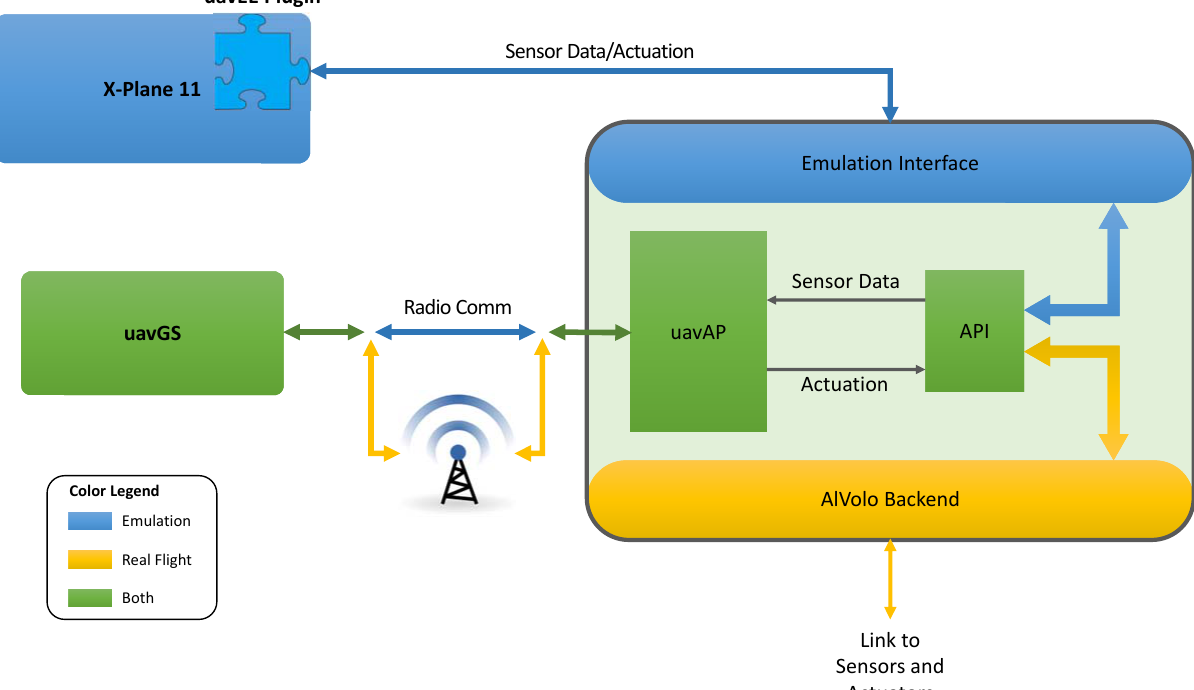
Figure 10. A system diagram of uavEE in emulation and real